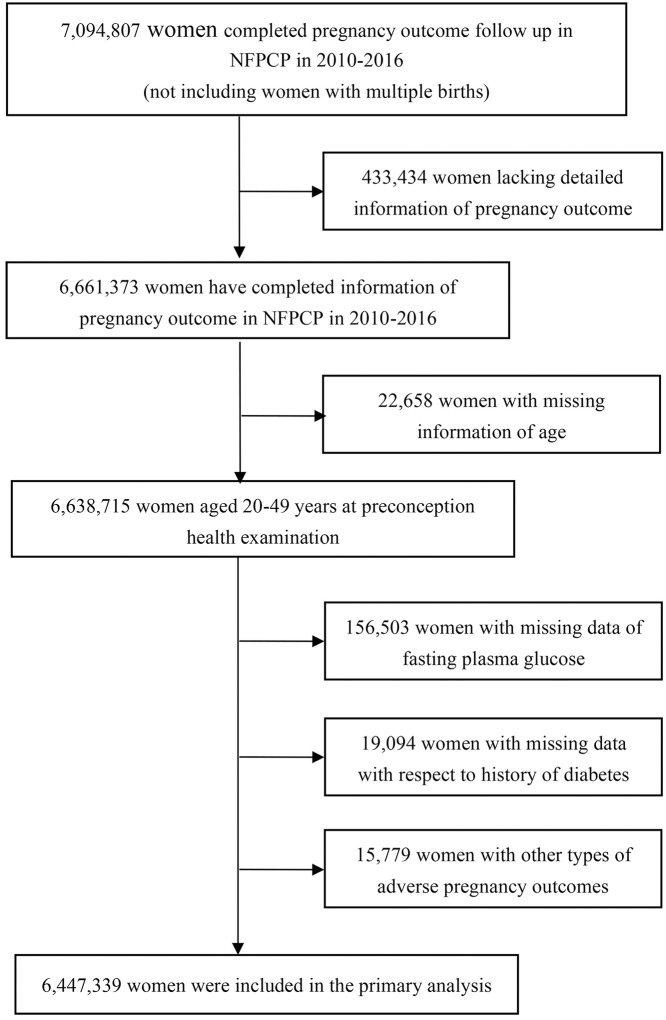
Flowchart of the study population.NFPCP, National Free Pre-Pregnancy Checkups Project.